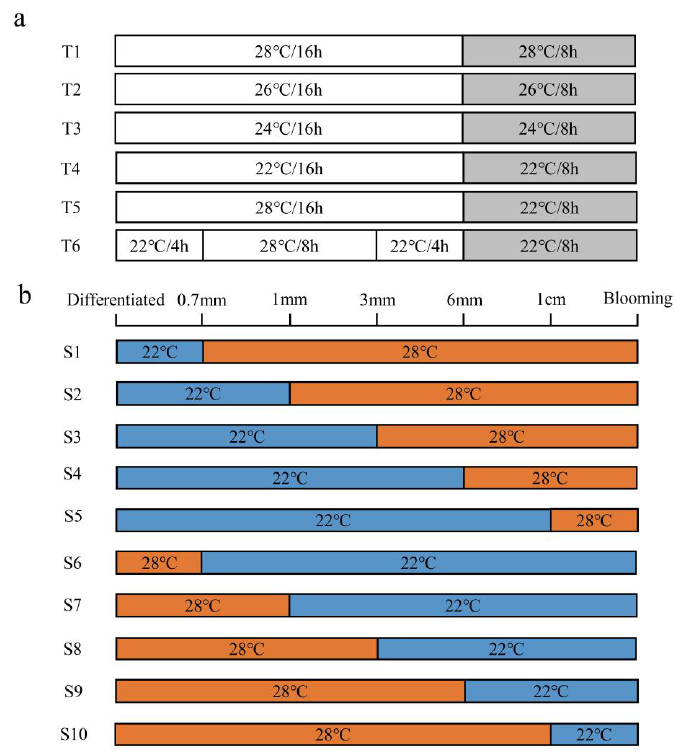
Figure 1. Different temperature treatments of ‘Red Twin’ every day from planting to blooming ( a ) and temperature-changing treatment of flower buds at different sizes ( b ). In T1-T6, the white box represents the light and the gray box represents the dark period, the different treatment temperatures and durations are shown in the box. S1–S5 represent flower buds that were transferred to 28 ◦ C from 22 ◦ C at 0.7 mm, 1 mm, 3 mm, 6 mm, and 1 cm, respectively. S6–S10 represent flower buds that were transferred to 22 ◦ C from 28 ◦ C at 0.7 mm, 1 mm, 3 mm, 6 mm, and 1 cm,